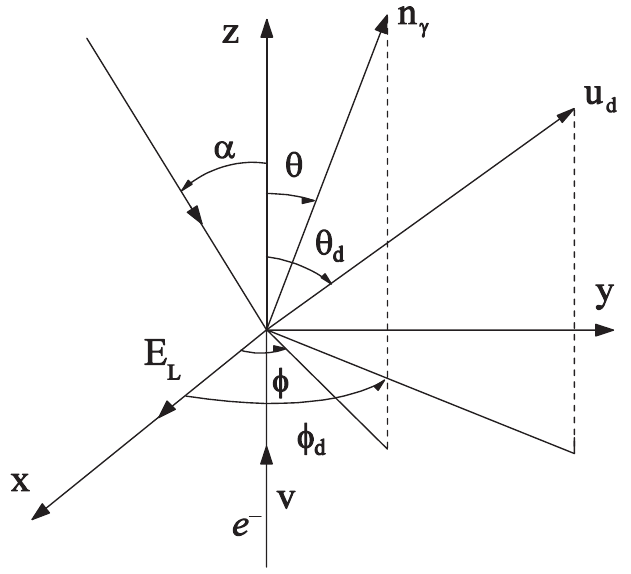
FIG. 2. Orientation in the case of a collision in the y - z plane. The x and y axes will be referred to as the vertical and horizontal axis, respectively. n tions, respectively. ( (cid:3); (cid:5) ) and ( (cid:3) angles, respectively. (cid:3) (cid:3); (cid:5) (cid:5) and (cid:3) (cid:3) tor angles, respectively, and E